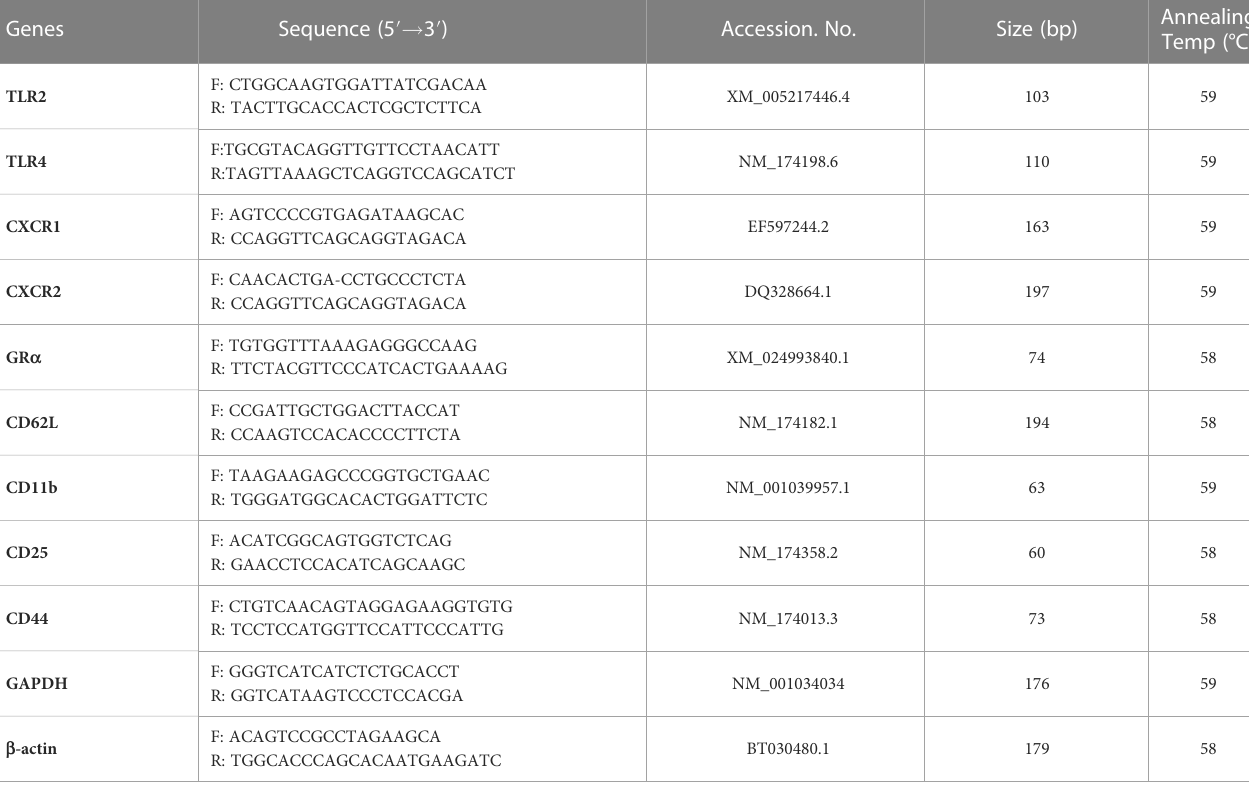
TABLE 2 Details of various primers used in the study.